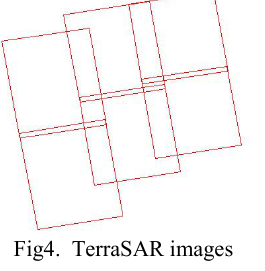
Table 2. Statistics for positioning accuracy of TerraSAR images